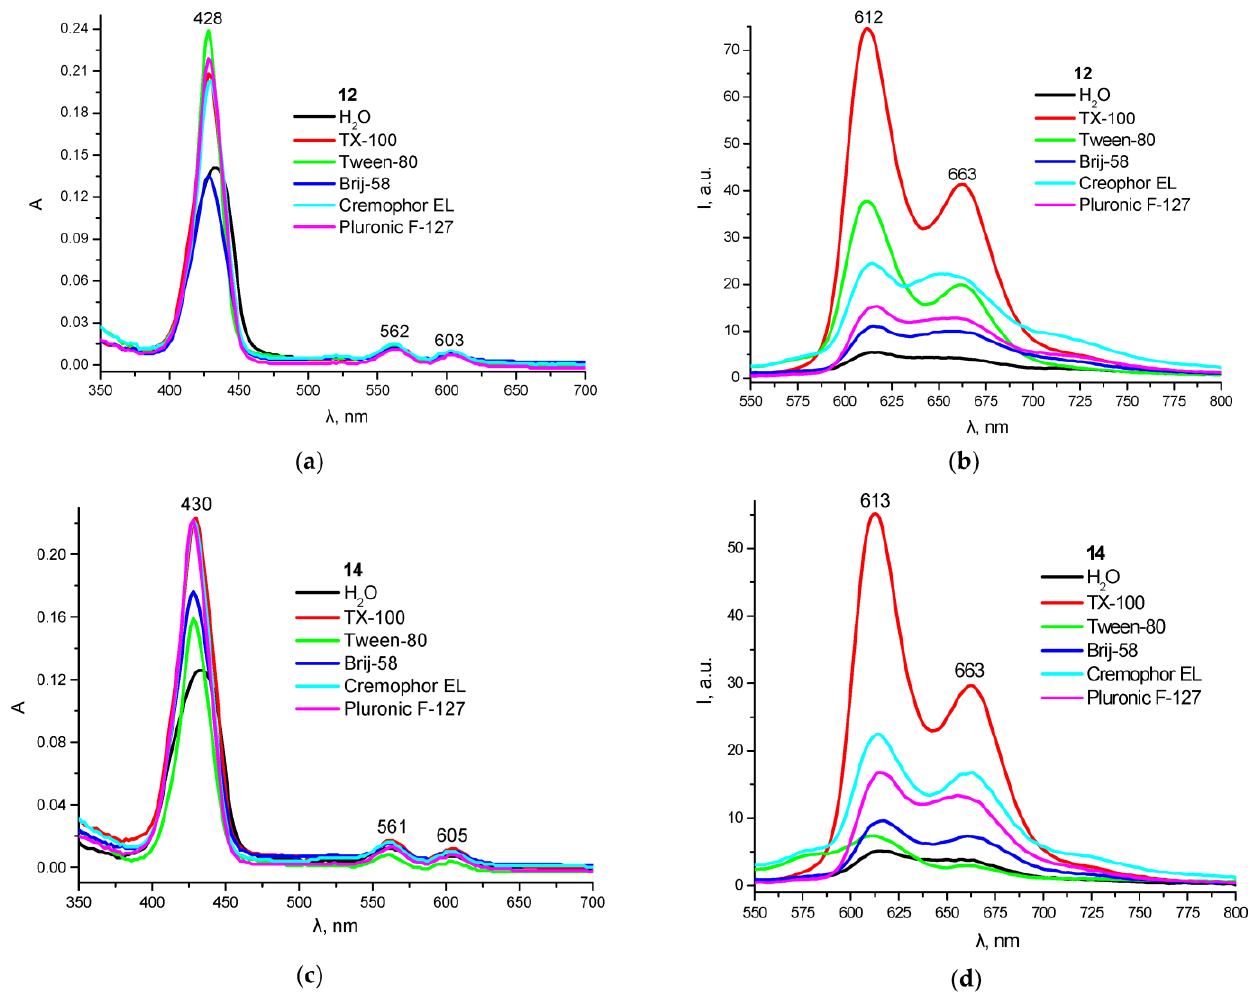
Figure 4. UV-Vis absorption ( a , c ) and fluorescence ( b , d ) spectra of 12 ( a , b ) and 14 ( c , d ) in water and aqueous solutions of different solubilizing agents ( С = 0.9 ± 0.05 μМ).